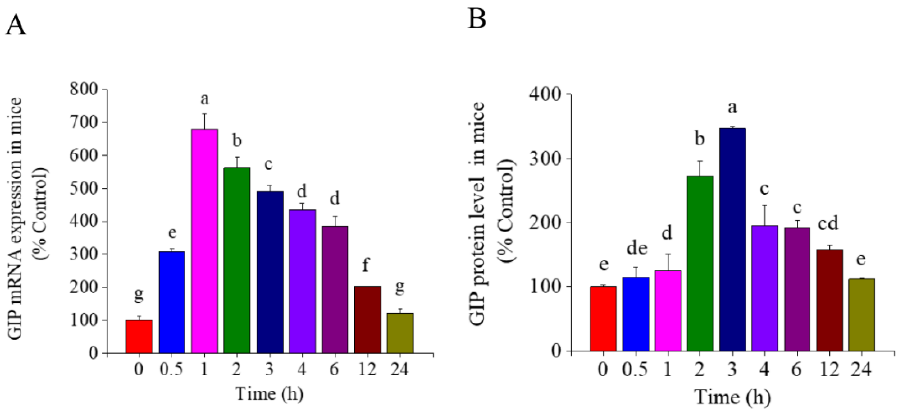
Figure 1. Effect of total tea seed saponins (TSS) on the GIP expression in the small intestine of mice. ( A ) The mRNA expression of GIP determined by RT-PCR. ( B ) The protein level of GIP determined by ELISA. Different letters indicate significant difference among groups ( p < 0.05).